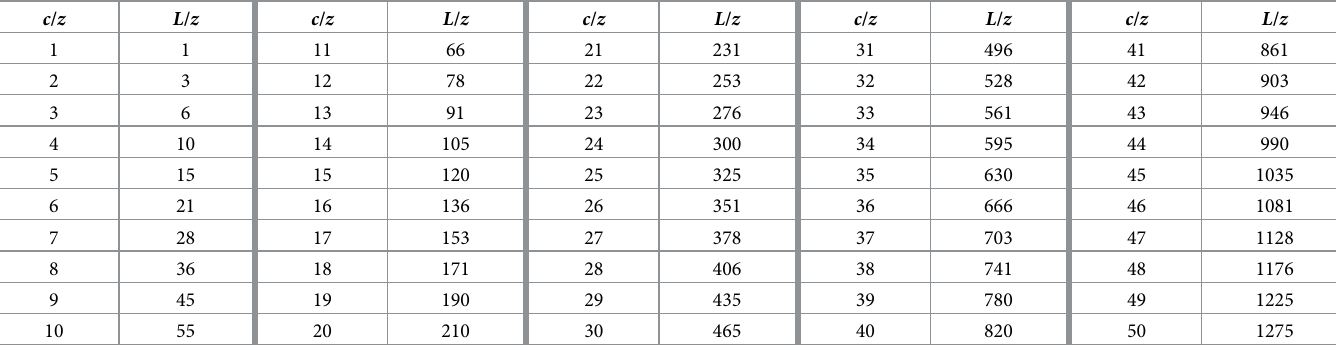
Table 1. Lookup table for the actual length of a spiral